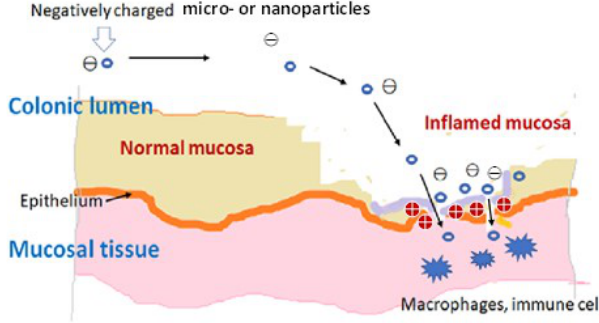
Figure 1. Potential accumulation of nanoparticles (NPs) in intervals of the colonic epithelial cell membrane due to the epithelial enhanced permeability and retention (eEPR) effect. membrane due to the epithelial enhanced permeability and retention (eEPR) e